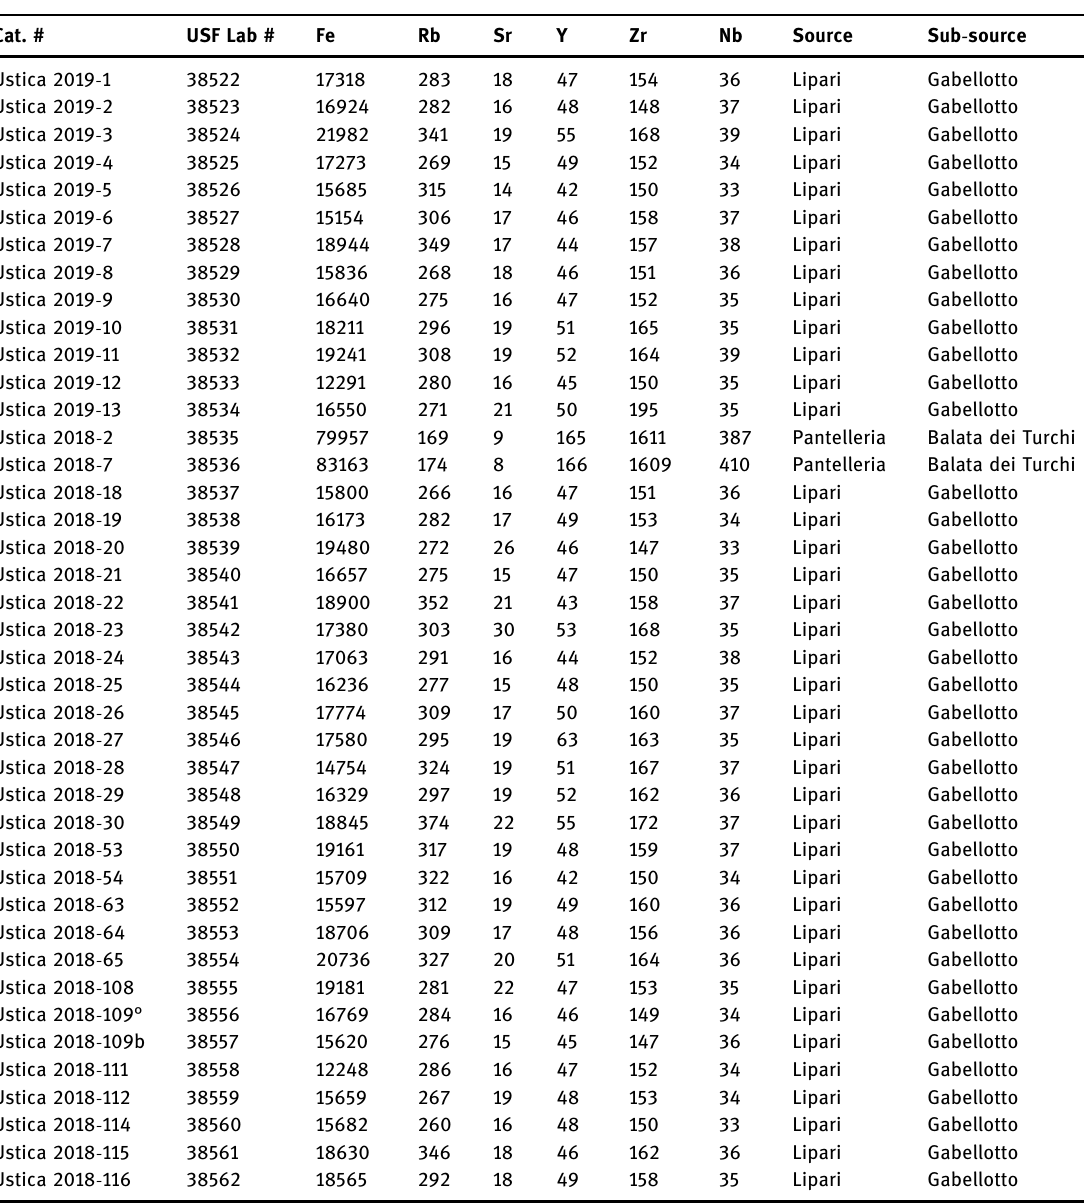
Table 2: Results of pXRF analyses from 41 obsidian items of Piano dei Cardoni Cat.